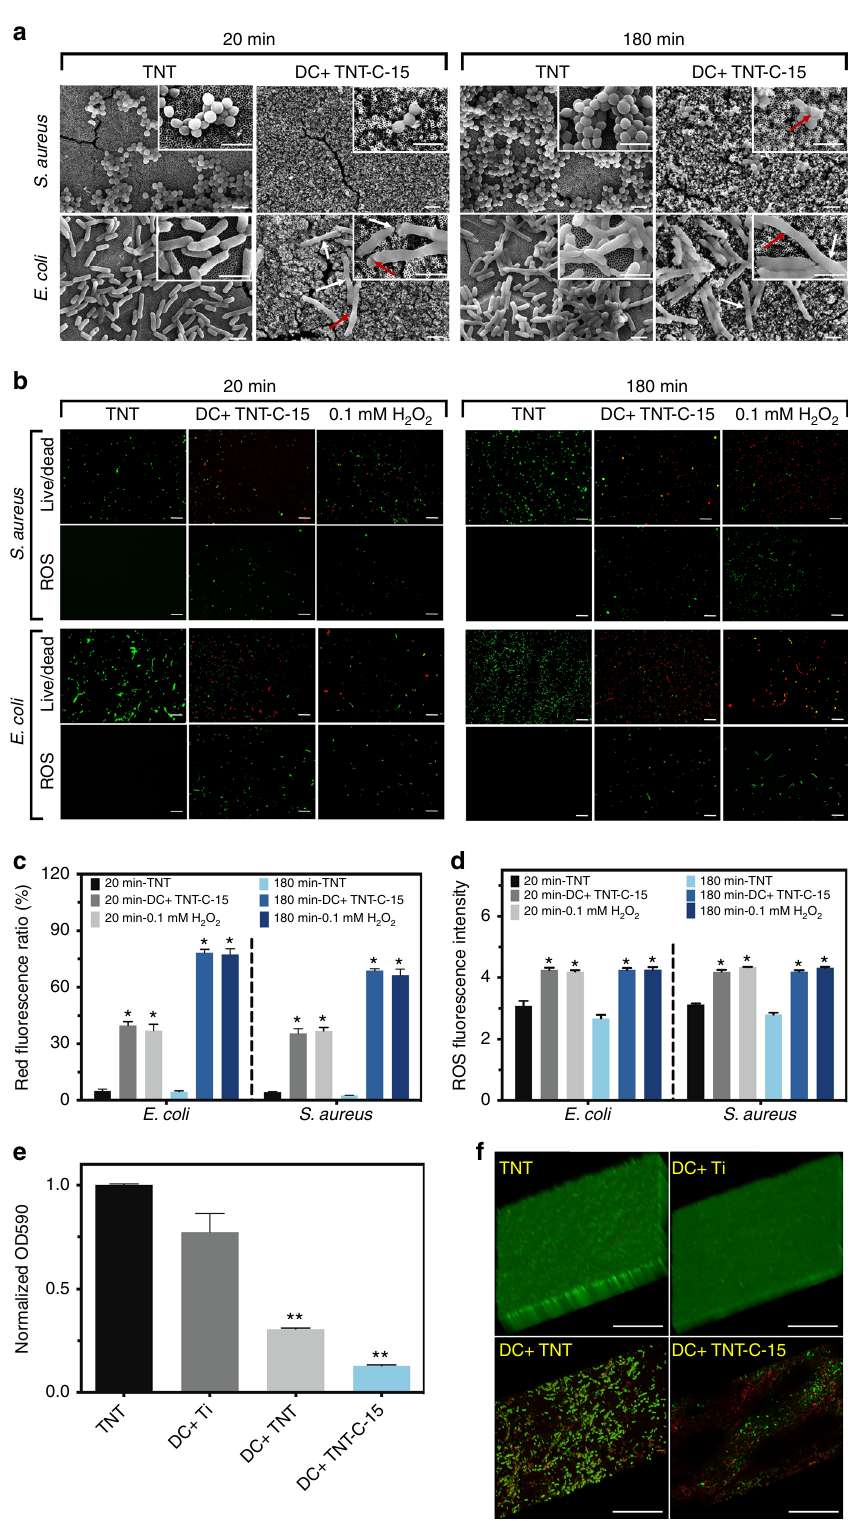
Fig. 5 Physiological changes of bacteria. a SEM images of S. aureus and E. coli on TNT control and the DC + charged TNT-C-15 (Scale bar = 2 μ m). b Live/ dead and ROS staining images of S. aureus and E. coli treated with TNT control, DC + charged TNT-C-15, and 0.1 mM H 2 O 2 (Scale bar = 20 μ m). c Quantitative analysis of the live/dead staining results by fl ow cytometry. d Quantitative analysis of the ROS fl uorescence intensity of treated bacteria by fl ow cytometry. e , f Anti-bio fi lm performances of various samples: e quantitative measurements after crystal violet staining and f 3D morphology of the fl uorescently stained bio fi lms (Scale bar = 50 μ m) (*denotes P < 0.05 and **denotes P < 0.01 compared with TNT group, Student t test). All error bars = s. d. ( n =